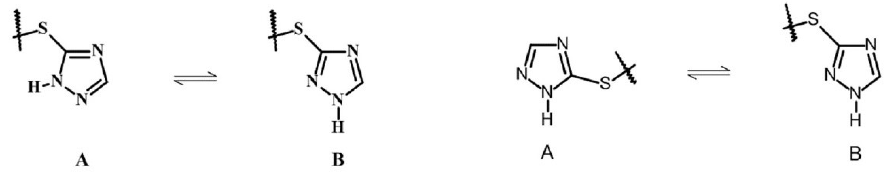
Figure 1. The molecular structures of compound 4 in the crystals 4(A) and 4(B) .